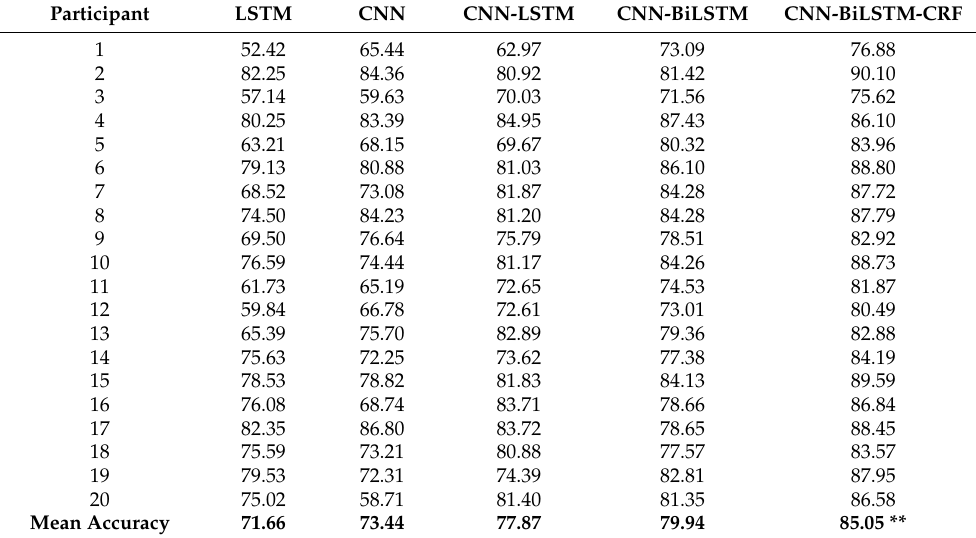
Table 4. Mean classification accuracy for each participant in Experiment 1 using a 10-fold cross- validation technique. Ten test runs were performed on each model, and the average of the results was calculated.